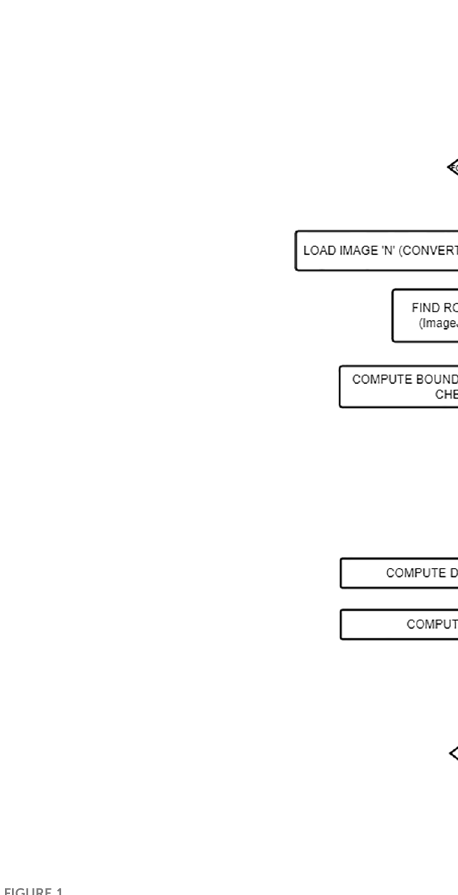
FIGURE 1 Work fl ow of the main algorithm for D W and SSDE